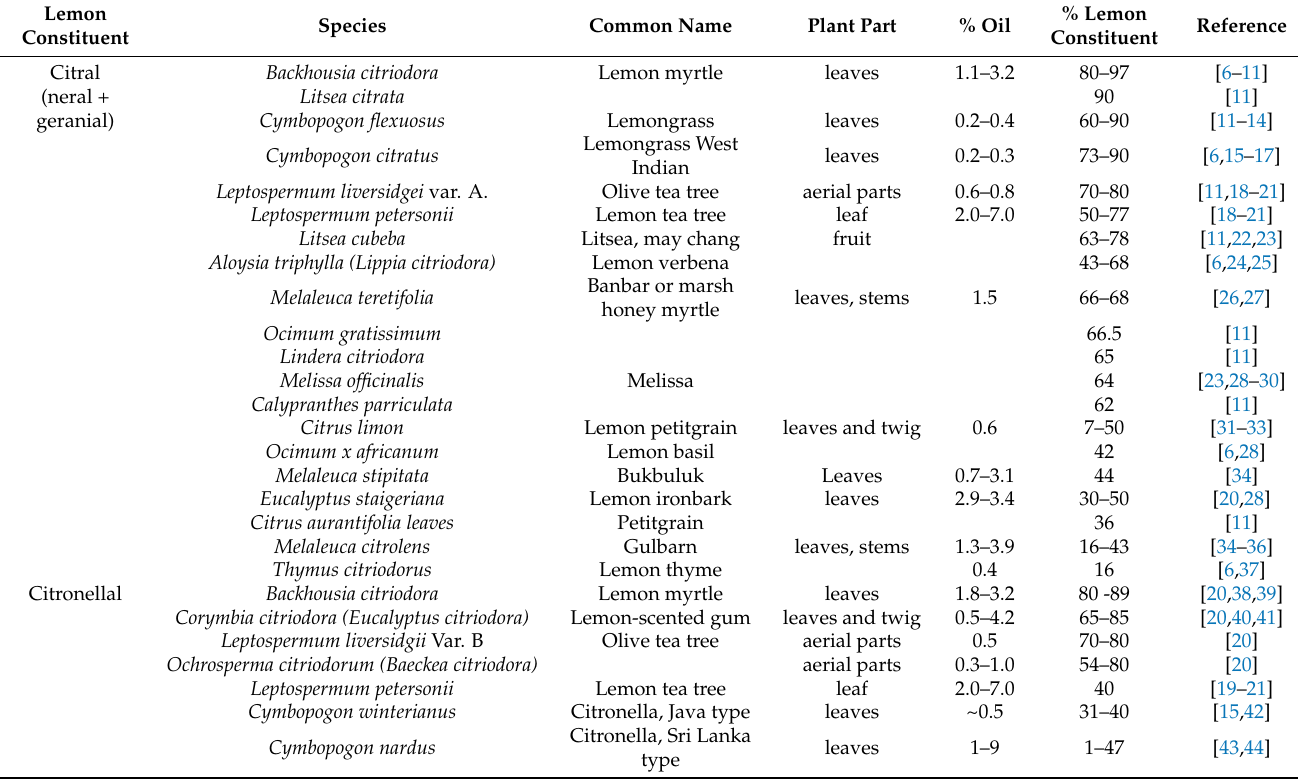
Table 1. Commercial and potentially commercial sources of citral (neral + geranial) and citronellal essential oil. Lemon